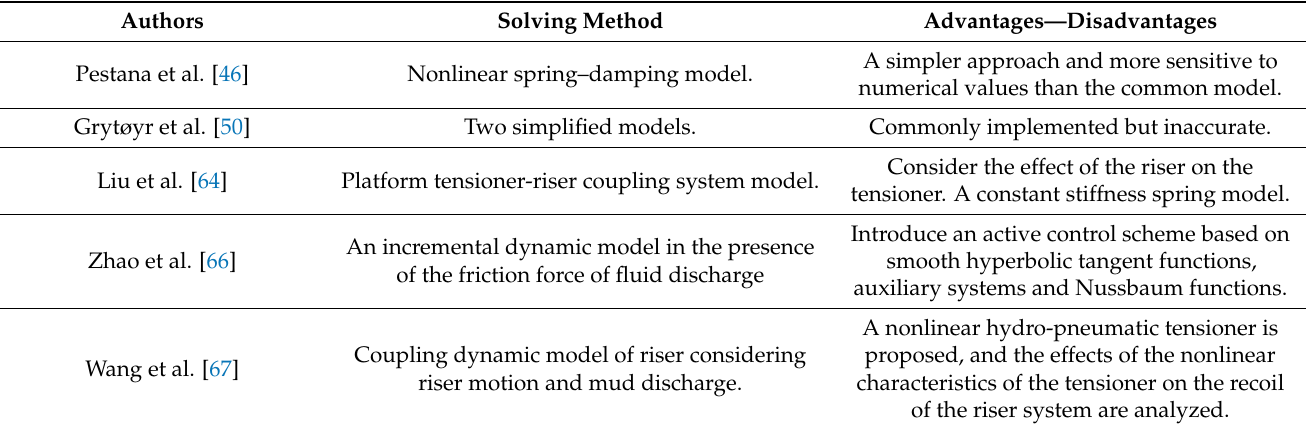
Table 3. The comparison of top tensioner